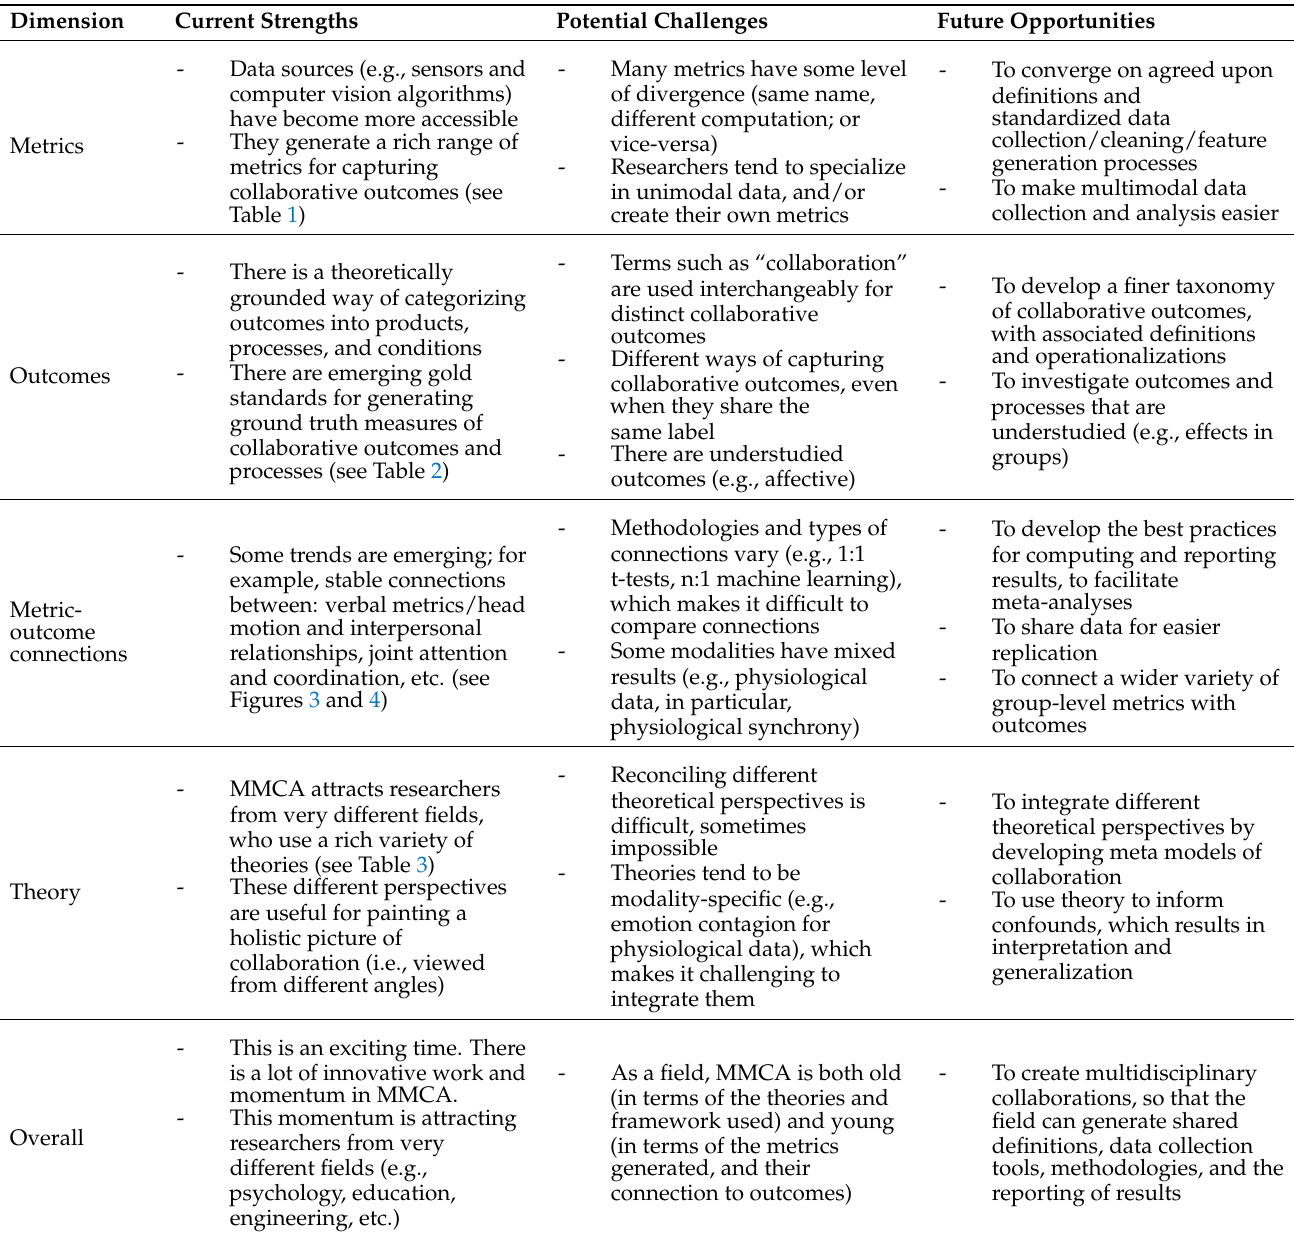
Table 4. Takeaways from this review of the field (strengths, challenges,